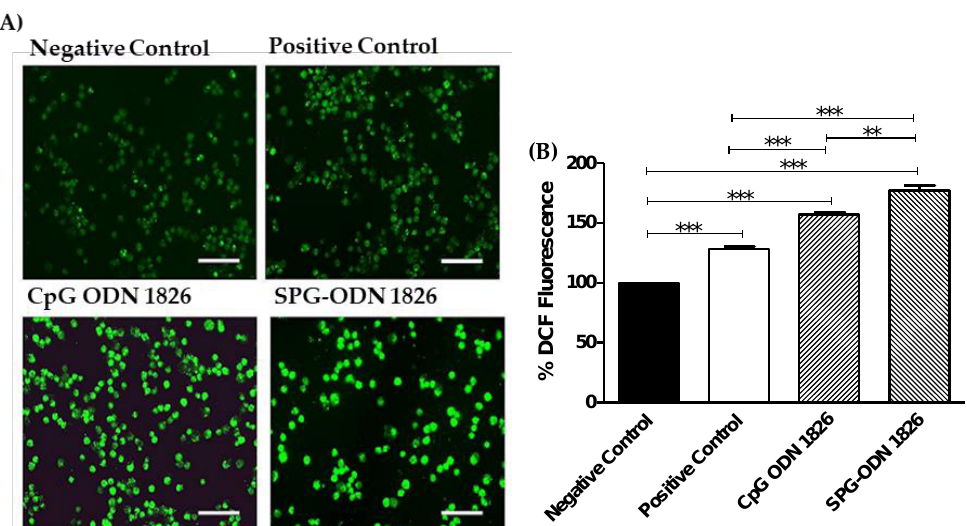
Figure 4. Augmentation of ROS levels within J774A.1 cells treated with TLR-9 agonist and SPG-ODN 1826 nanovehicles. ( A ) Photomicrographs indicating augmented ROS in DCF-DA-positive J774A.1 cells treated with CpG ODN 1826 and nanovehicles. ( B ) Quantification of DCF-DA-mediated fluorescence within J774A.1 cells treated with TLR-9 agonist and formulated nanovehicles. Scale bar = 100 µm. Data presented are the mean ± SEM of three individual experiments, where each was performed individually thrice. Statistical significance between different groups was ascertained using one-way ANOVA and Tukey ’s post hoc test where ** p < 0.01 and *** p < 0.001.